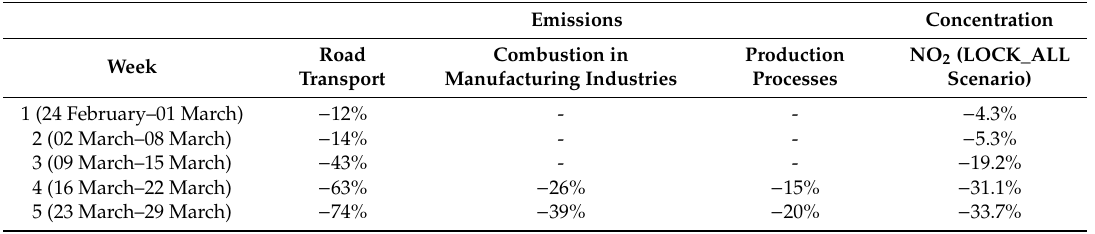
Table 1. Weekly average emission reduction coe ffi cients calculated for the Lombardy region and corresponding NO 2 average weekly concentration reduction estimated by the LOCK_ALL